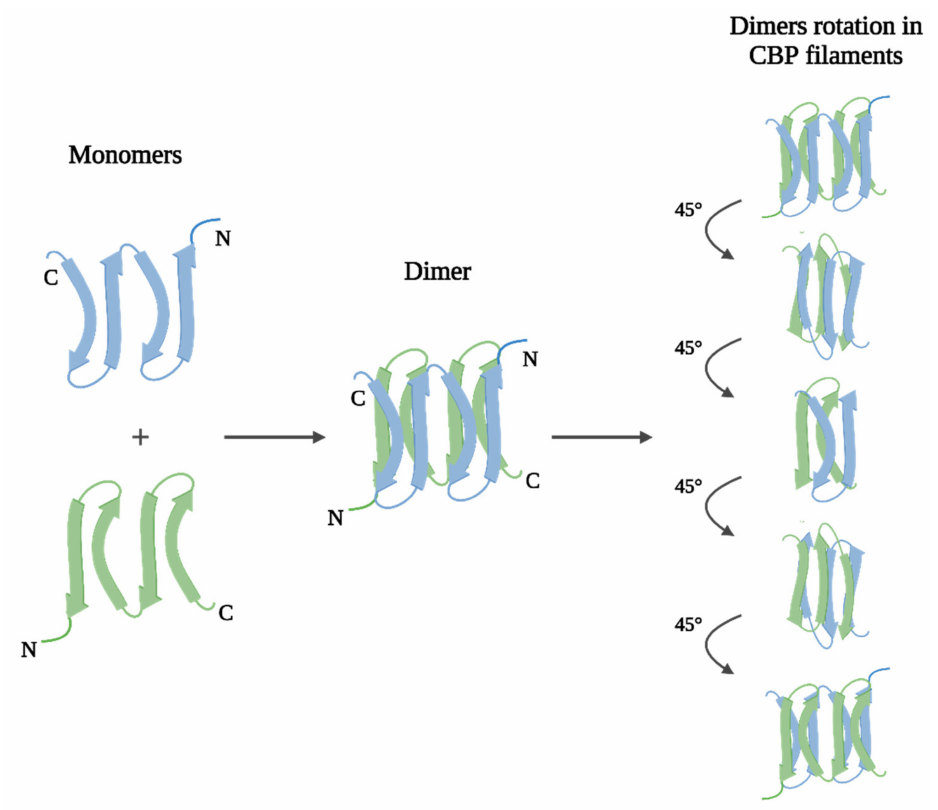
Figure 3. Filament structure of corneous beta-proteins (created with BioRender.com, access date: 9 November